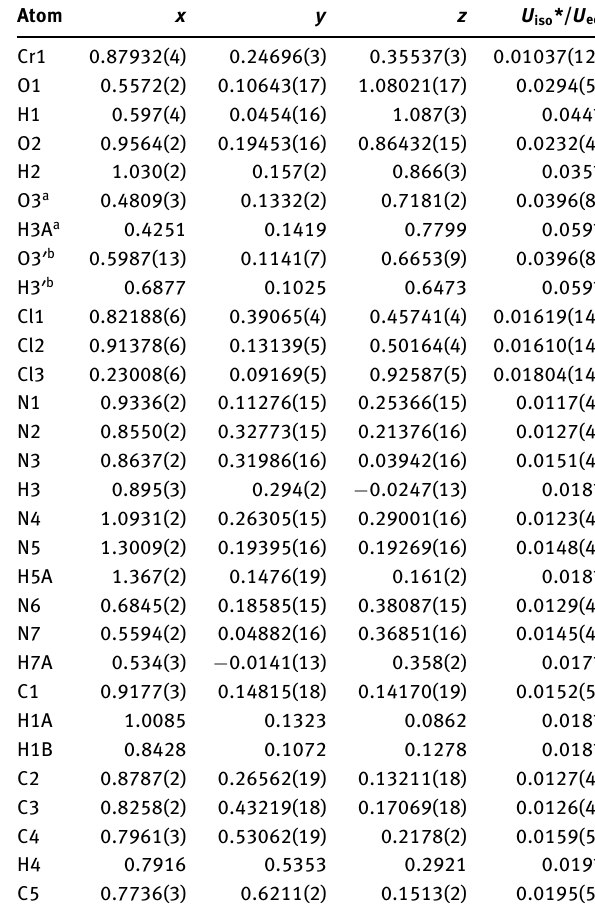
Table 2: Fractional atomic coordinates and isotropic or equivalent isotropic displacement parameters (Å 2